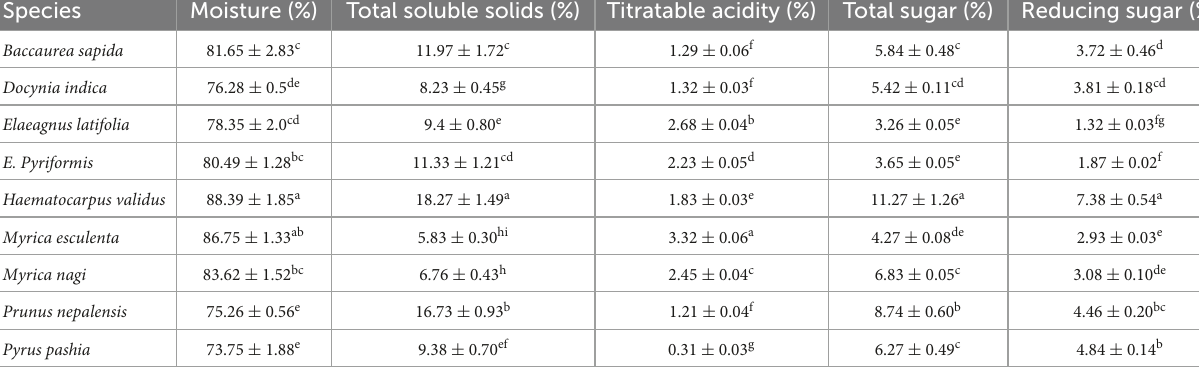
TABLE 3 Biochemical characteristics of wild edible fruits grown in the eastern Himalayas, India. Species Moisture (%) Total soluble solids (%) Titratable acidity (%) Total sugar (%) Reducing sugar (%)